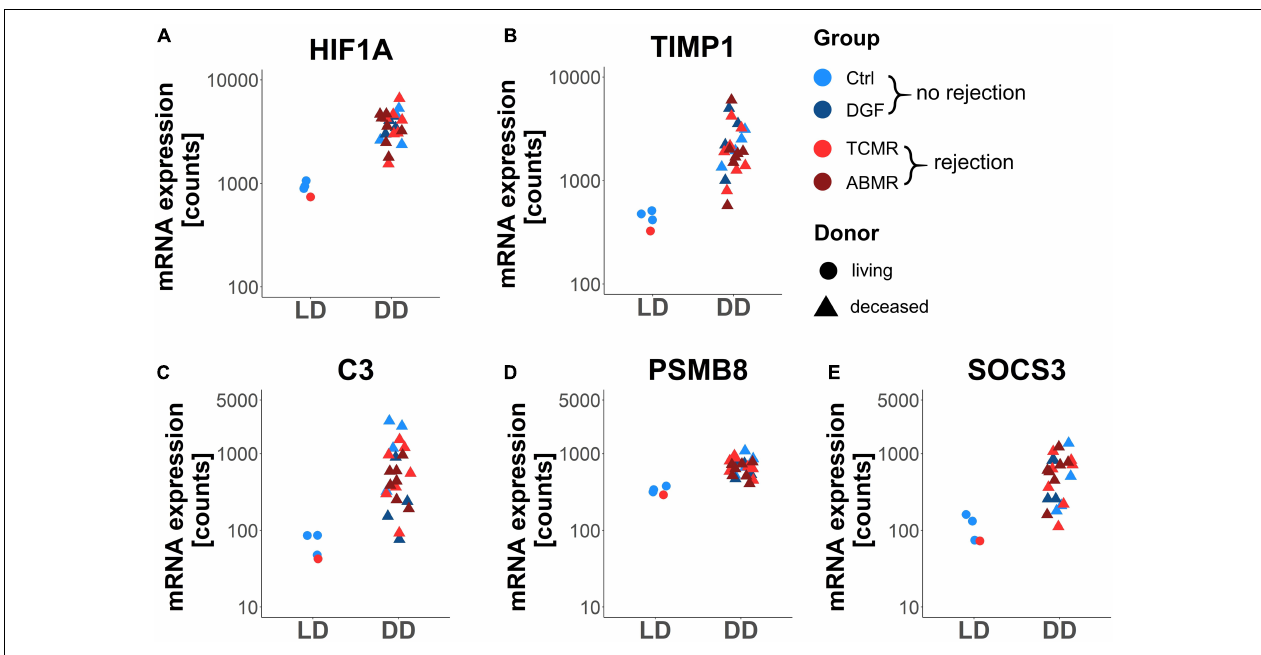
FIGURE 3 | Expression of the top 5 differentially expressed genes between deceased (DD) and living donors (LD) associated with the enriched pathway “post-translational protein modification”. Dot plots showing gene expression (normalized counts) of the genes HIF1A (A) , TIMP1 (B) , C3 (C) , PSMB8 (D) , and SOCS3 (E) in zero-time biopsies of living (LD) and deceased (DD) donors. Adjusted p < 0.05 for all shown genes.